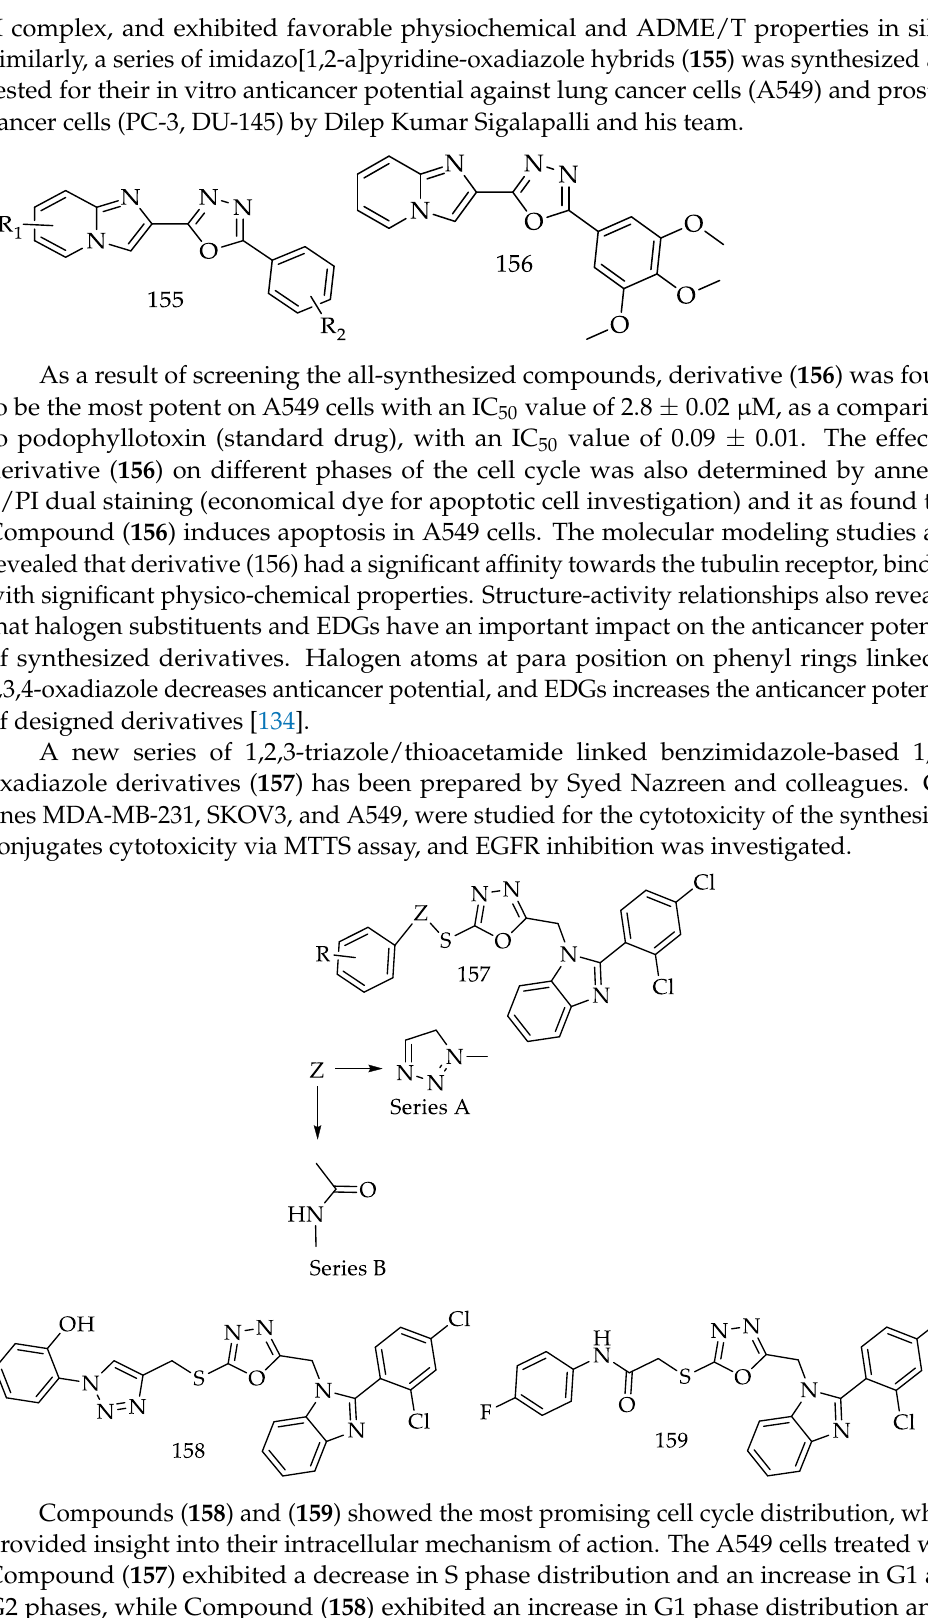
Figure 23. The structure-activity relationship of pyrimidine-1,3,4-oxadiazole analogues. Further, a mixture of molecular modeling and target-based assay studies proved that Compound (154) was well accommodated at the active site of the DNA topoisomerase II complex, and exhibited favorable physiochemical and ADME/T properties in silico. Sim- ilarly, a series of imidazo[1,2-a]pyridine-oxadiazole hybrids (155) was synthesized and tested for their in vitro anticancer potential against lung cancer cells (A549) and prostate cancer cells (PC-3, DU-145) by Dilep Kumar Sigalapalli and his team.